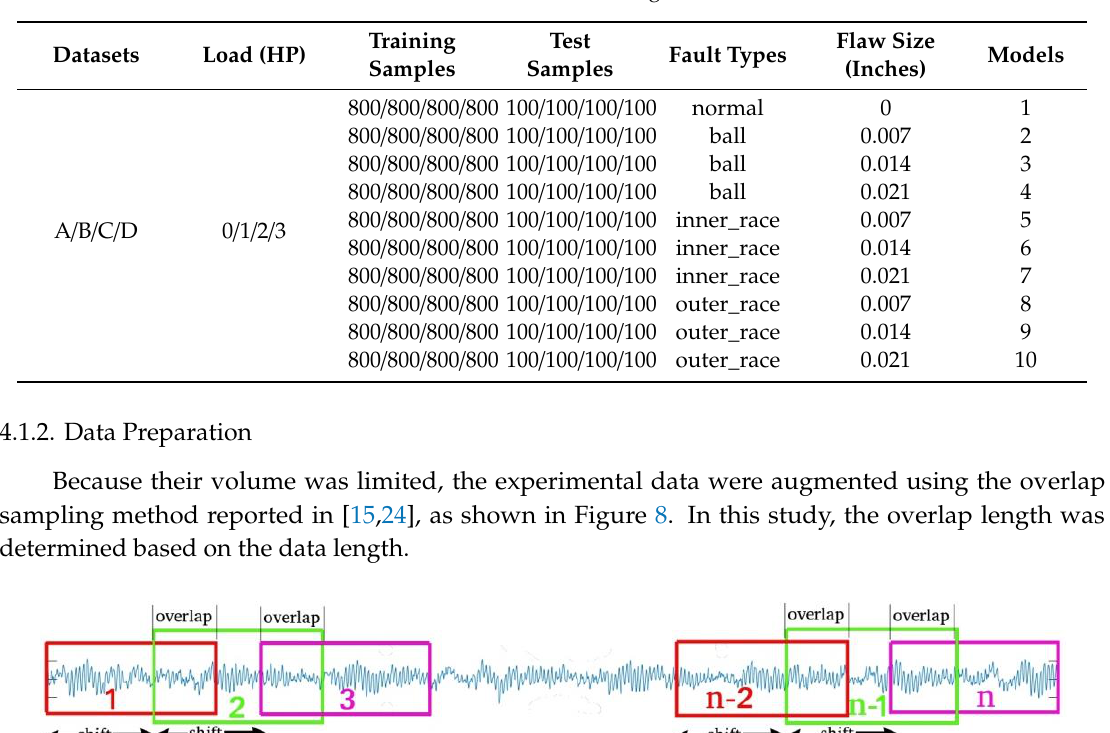
Table 5. Classification of the bearing fault datasets.